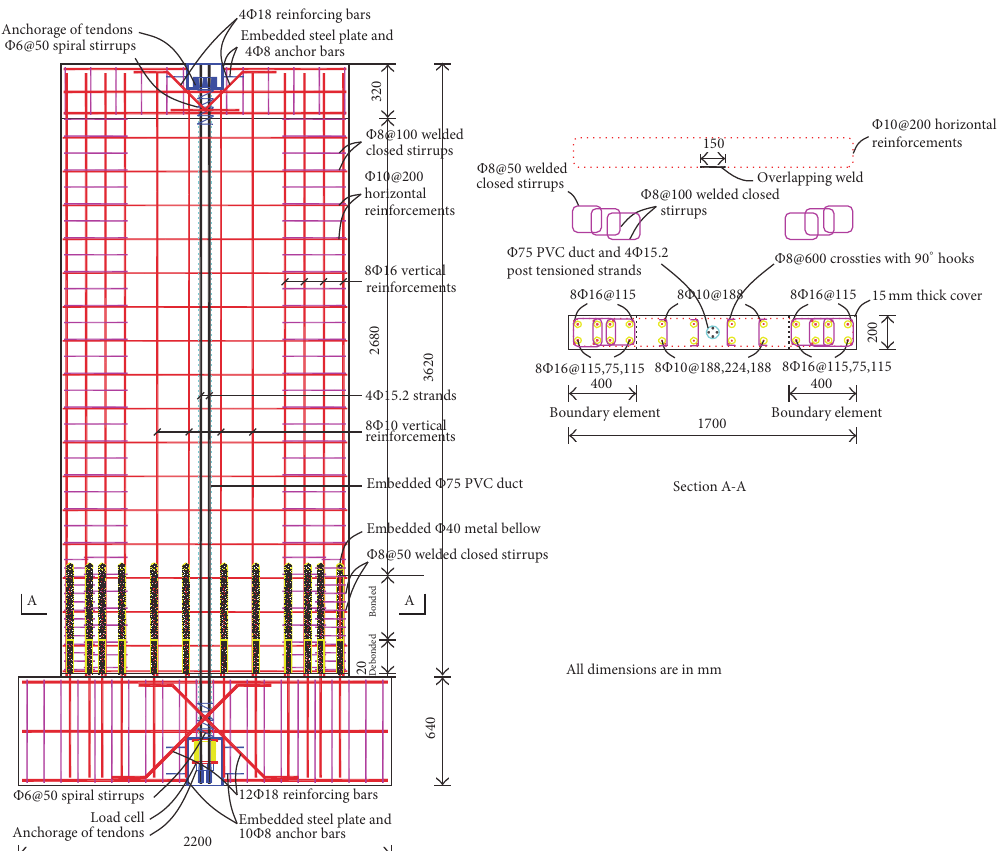
Figure 3: Details of HPWEM